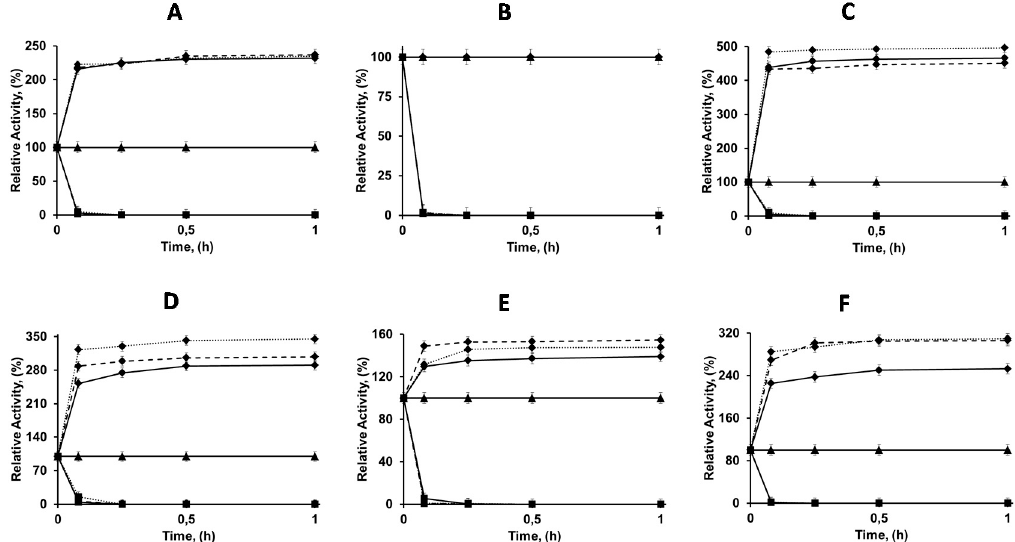
Figure 3. Immobilization courses of different lipases on several octyl agarose supports, OC (Dotted line), OCEDA (Solid black line) and OCHDA (Dashed line). Immobilizations were performed in 50 mM buffer sodium acetate at pH 5 and 25 °C. Other specifications are described in Section 2. ( A ) CALA, ( B ) CALB, ( C ) CRL, ( D ) RML, ( E ) TLL and ( F ) LU. Rhombus (suspension), square (Supernatant), triangle (Soluble enzyme).